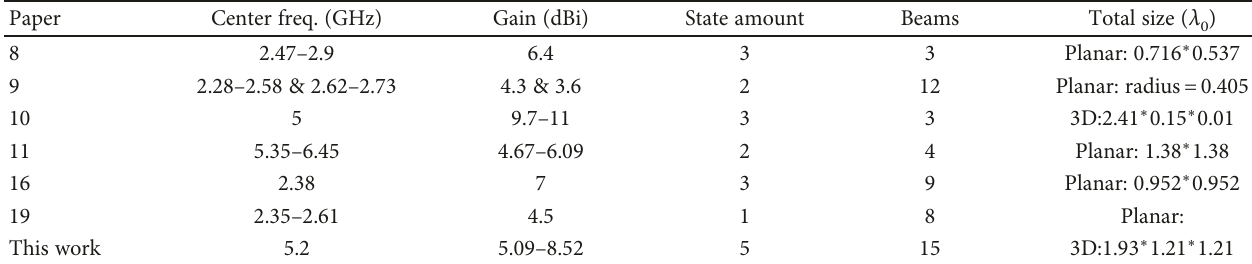
Table 2: Comparison of proposed and reference